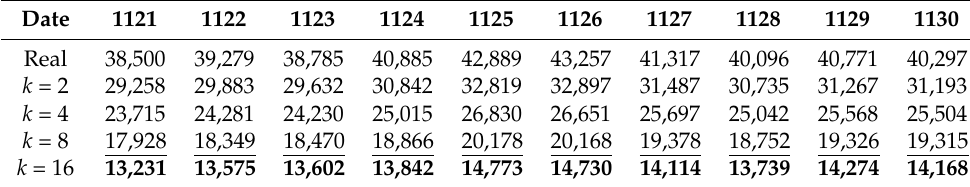
Table 3. The effective fleet size in CTPURec with different k .